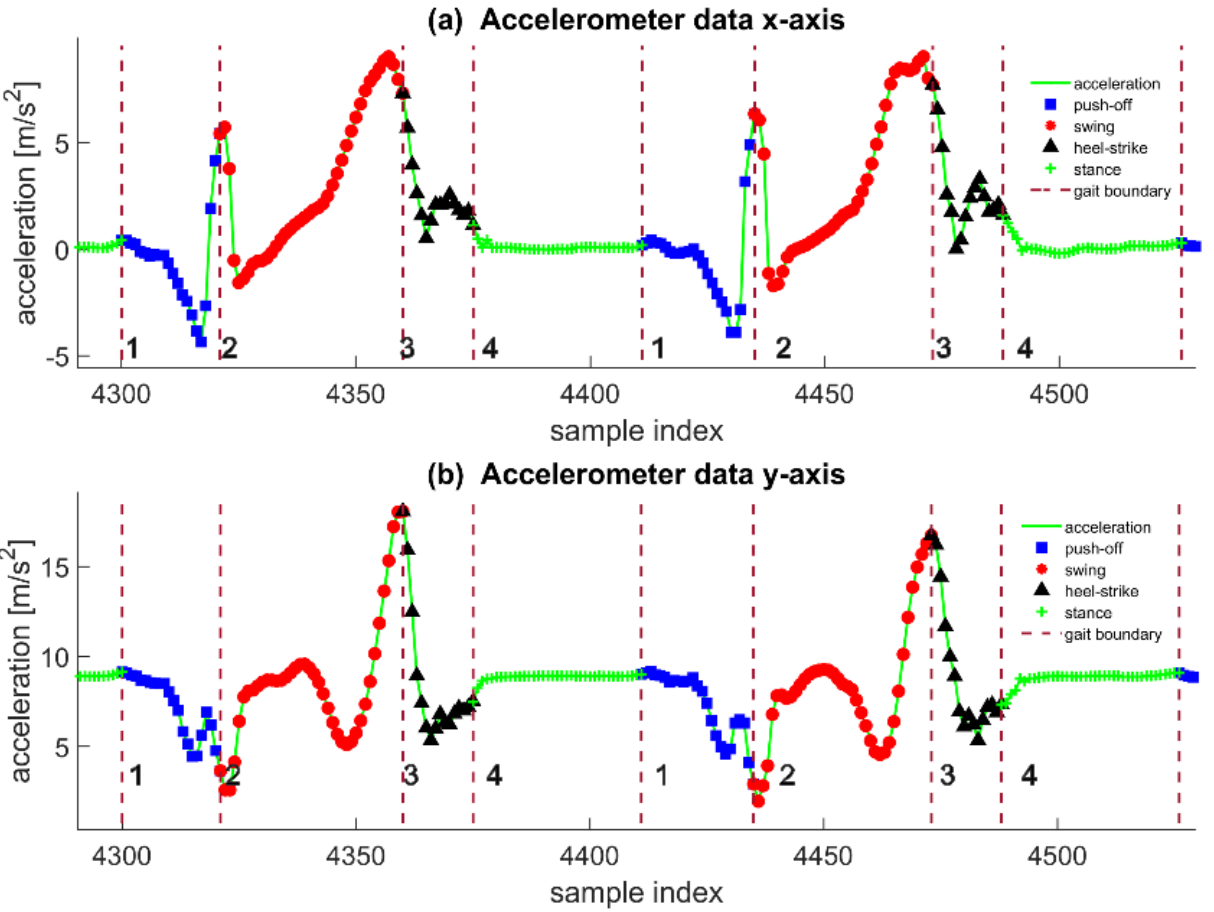
Figure 5. Gait segmentation label display. ( a ) Annotated gait phases in sagittal acceleration data; ( b ) Annotated gait phases in vertical acceleration data.